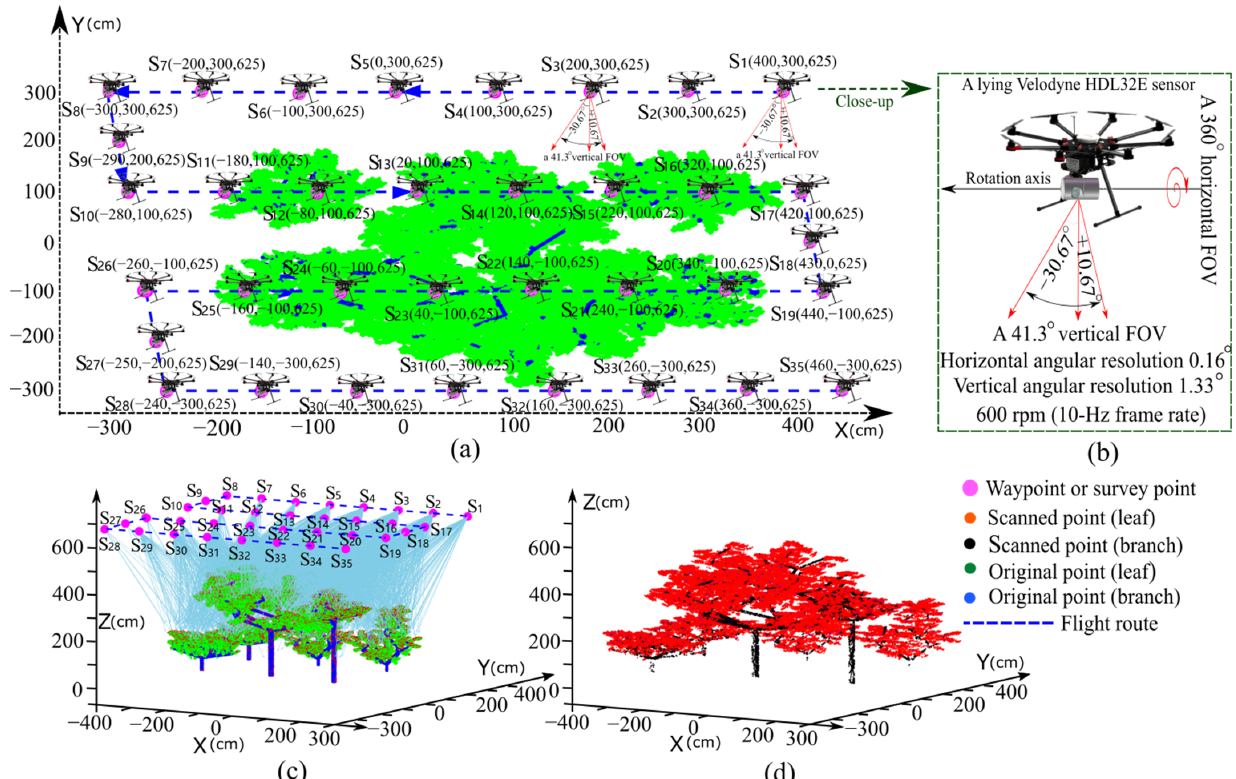
Figure 4. Our program diagram shows the simulation workflow of our aerial LiDAR scanning process. ( a , c ) The predetermined survey route of our flights with a controllable flight speed covering the study site and a top-down scanning pattern. ( b ) A lying HDL-32E sensor is mounted under the UAV to produce a 41.3° vertical FOV and a 360° horizontal FOV with adjustable angular resolutions, respectively. ( d ) Final scanning results show sparsely scanned data of the target forest plot, with occlusion dominating in the lower part of the forest canopy.